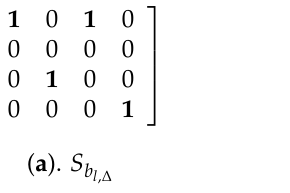
; ( b ) eroded frame R b l , ∆